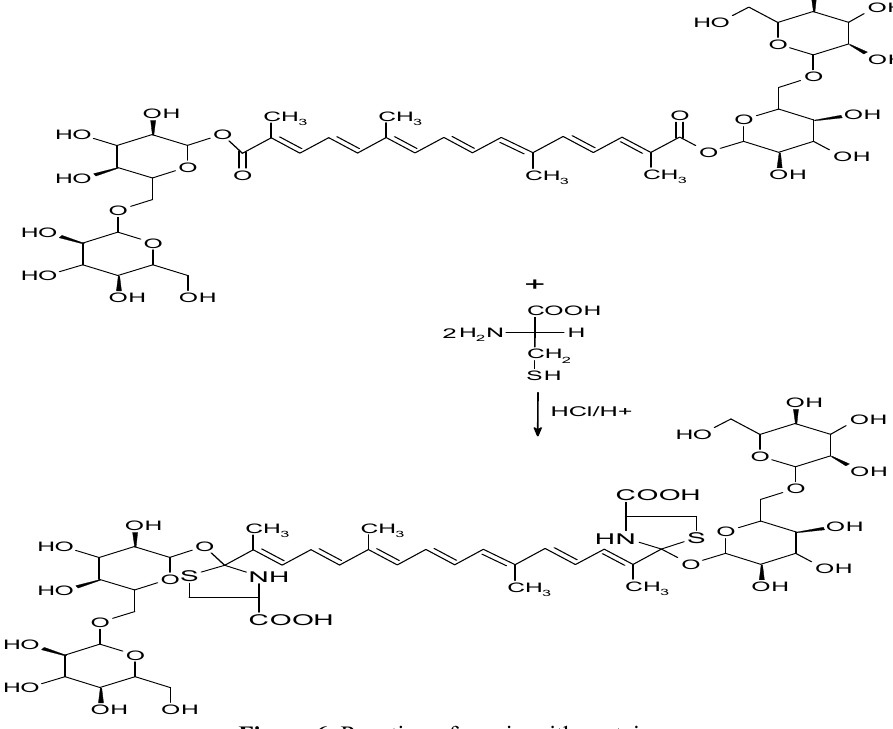
Figure 6. Reaction of crocin with